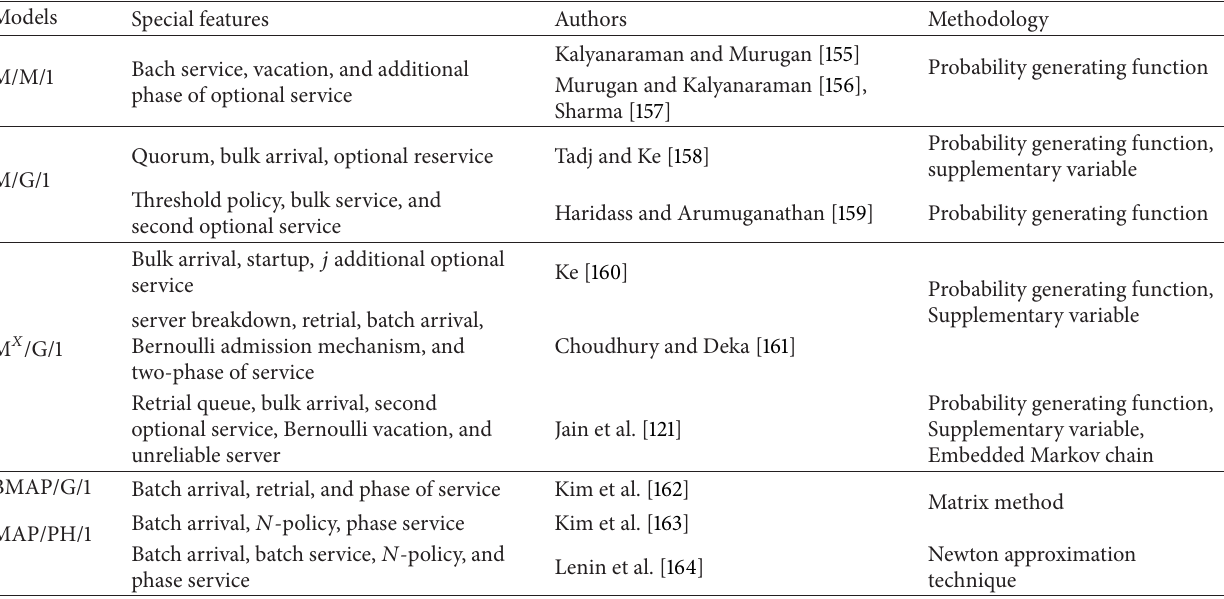
Table 5: Literature on bulk queues with phase